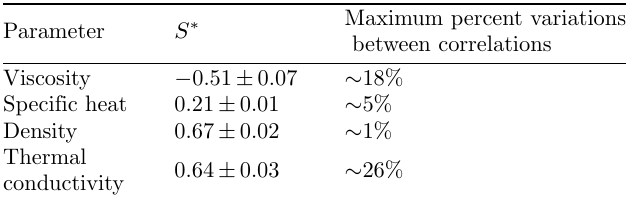
Fig. 9. Results of the sensitivity analysis 34. Table 7. Dimensionless sensitivity coefficients for each property, and their respective maximum variation deter- mined by the different